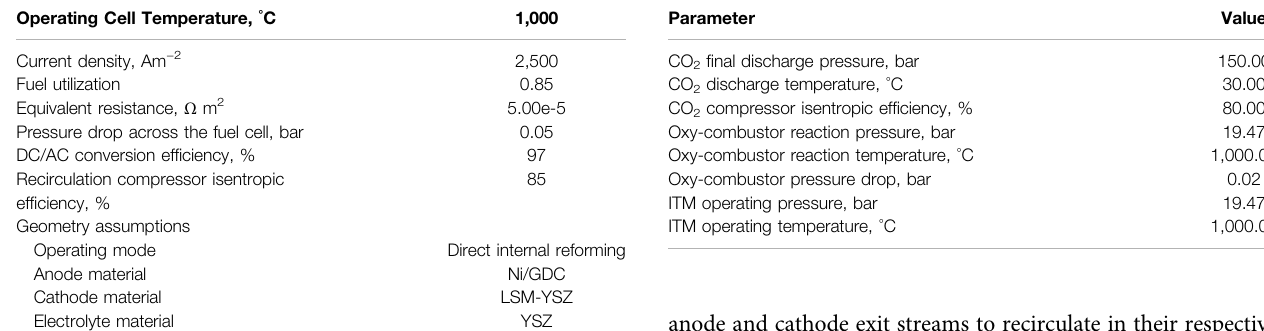
TABLE 2 | Important operating parameters of the SOFC model.